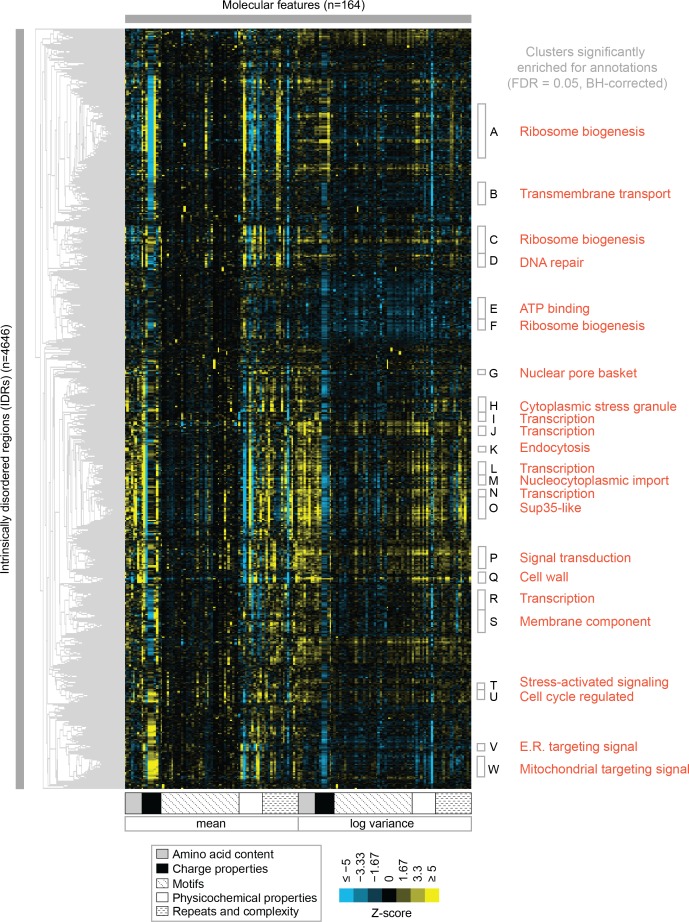
Clustering evolutionary signatures shows that IDRs in the proteome share evolutionary signatures, and that these clusters of IDRs are associated with specific biological functions.A-W show clusters significantly enriched for annotations (see Table 1; full table of enrichments in supplementary data). Cluster names represent summary of enriched annotations.Figure 3—source data 1.Clustered IDR data and mapping between IDRs and Cluster ID assigned in Figure 3.